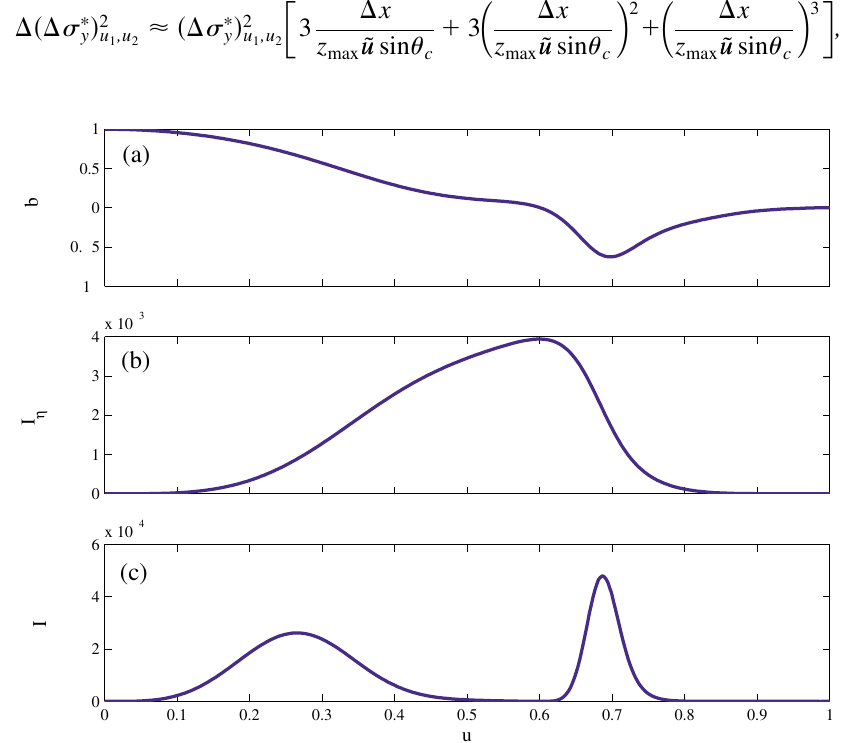
FIG. 5. (Color) Functions related to vertical beam size growth from quantum fluctuations in synchrotron radiation: (a) normalized ; (c) integrand of Eq. (15), I , as defined in the deflecting field b ; (b) dispersion integral I (cid:18)